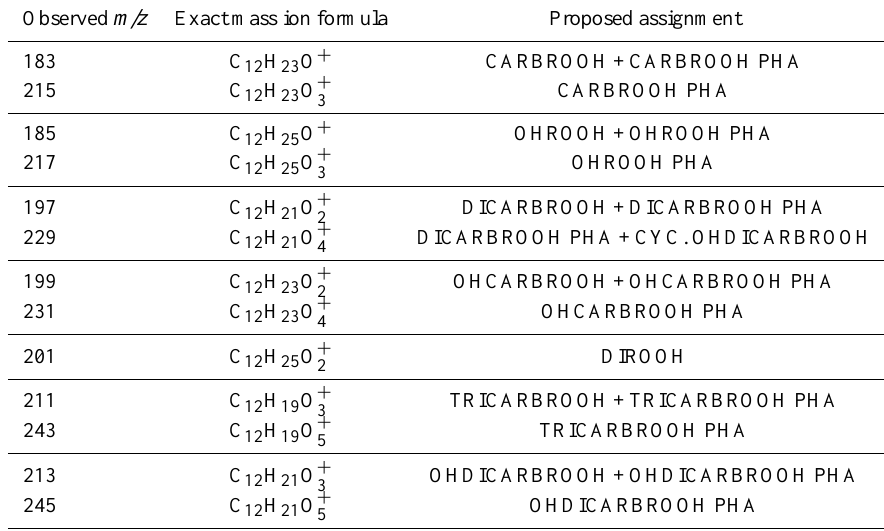
Table 5. Selected ions monitored by the AMS in the n -dodecane and 2-methylundecane systems. Observed m/z